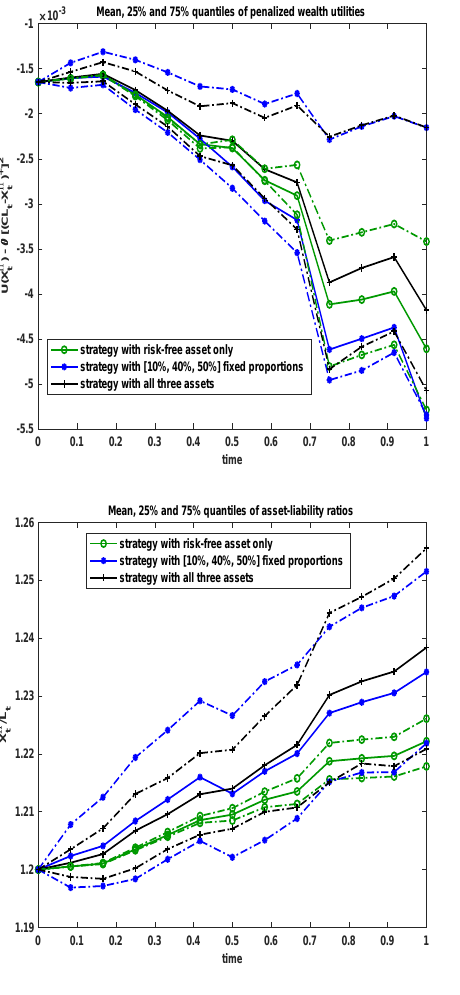
Figure 3. Empirical mean: 25% and 75 % quantiles of the penalized utilities of wealth ( upper left ), asset values ( upper right ), and asset-liability ratios ( bottom ) when using the risk-free asset only, when using fixed proportions invested in the three considered assets (10% in the risk-free asset, 40% in the default-free bond, and 50% in the default-sensitive bond), and when using the optimal proportions in the three assets as solution of